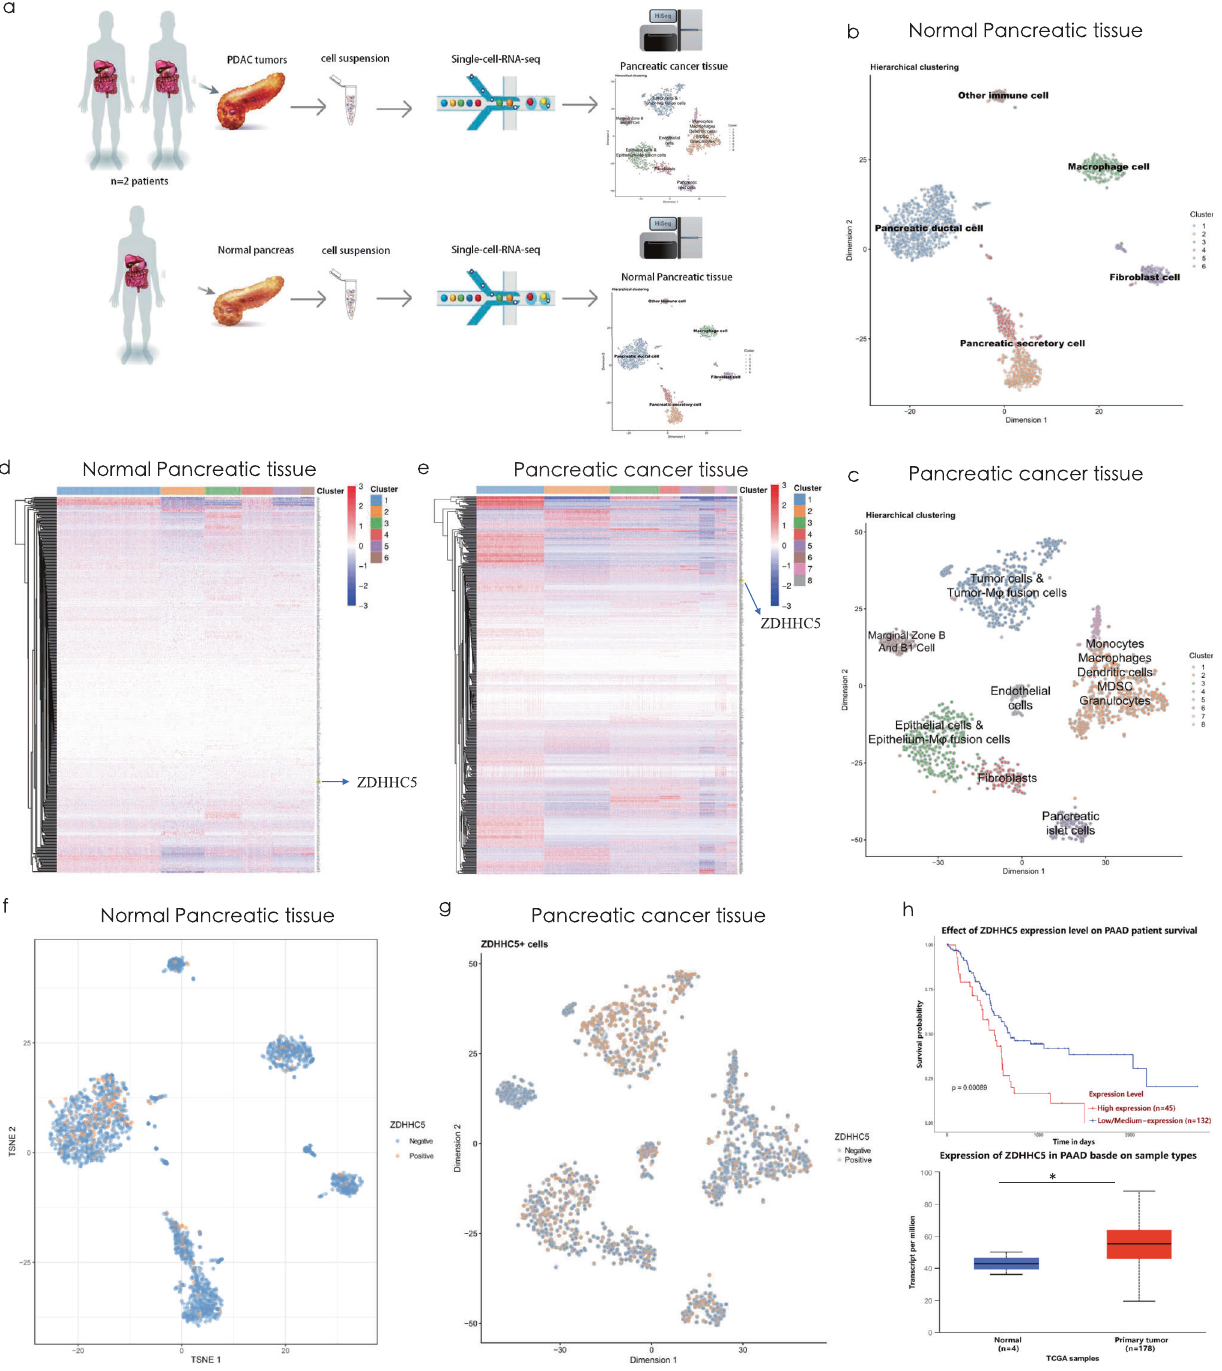
Fig. 1 Single-cell sequencing of normal pancreatic tissue and pancreatic cancer tissue, and TCGA database analysis. a Flow chart of single cell sequencing. b Single cell sequencing of normal pancreas tissue, t-SNE analysis. c Single cell sequencing of tumor sample, t-SNE analysis. d , f ZDHHC5 expressing in normal pancreas tissue (heatmap and t-SNE analysis). e , g ZDHHC5 expressing in tumor sample (heatmap and t-SNE analysis). h TCGA public pancreatic cancer samples, the survival rate of ZDHHC5 (high expression, n = 45) patients and ZDHHC5 (low expression, n = 132) patients (upper) and the expression level of ZDHHC5 in pancreatic cancer patients ( n = 178) or normal pancreas samples ( n =